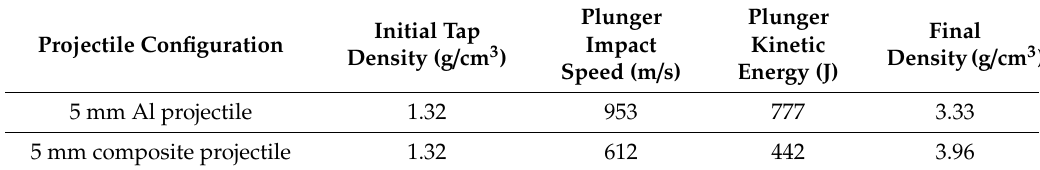
Table 1. Experimental setup parameters and the result obtained using di ff erent projectile